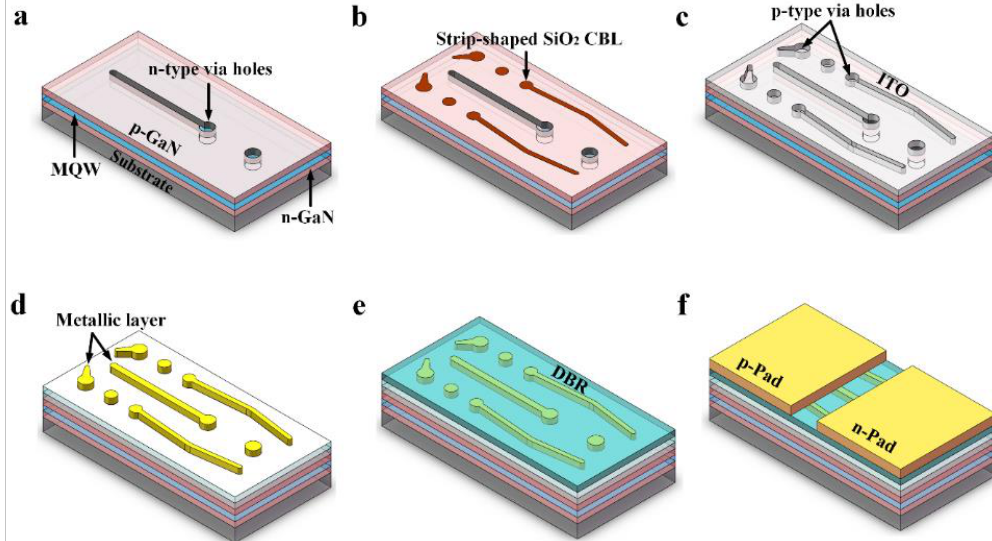
Figure 1. Schematic illustration of the fabrication process for a FCLED with DBR.